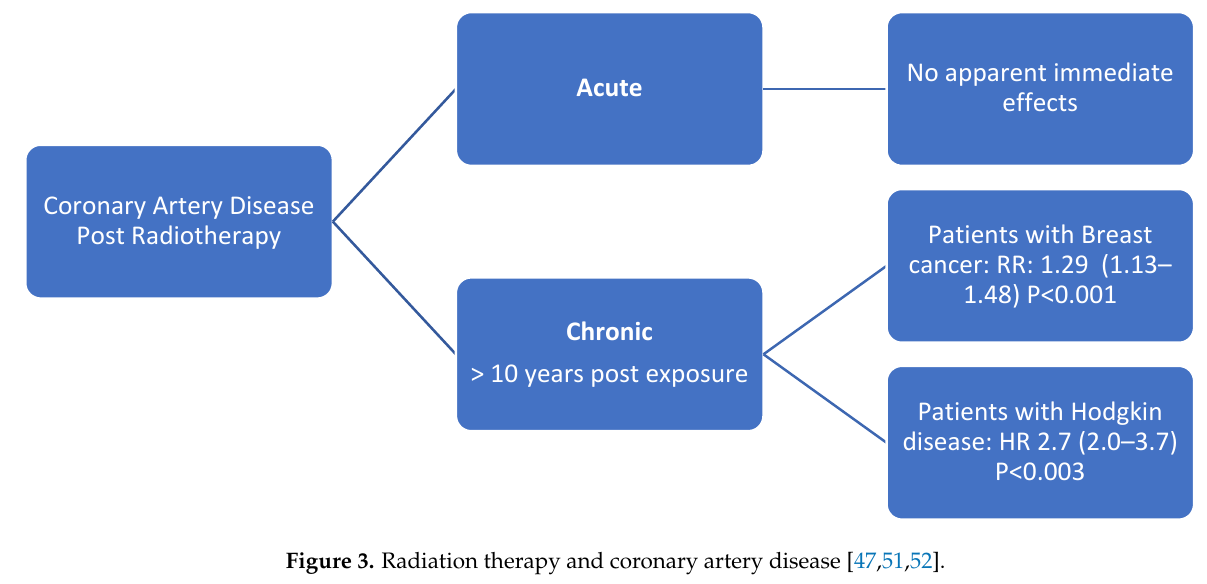
Figure 3. Radiation therapy and coronary artery disease [47,51,52].